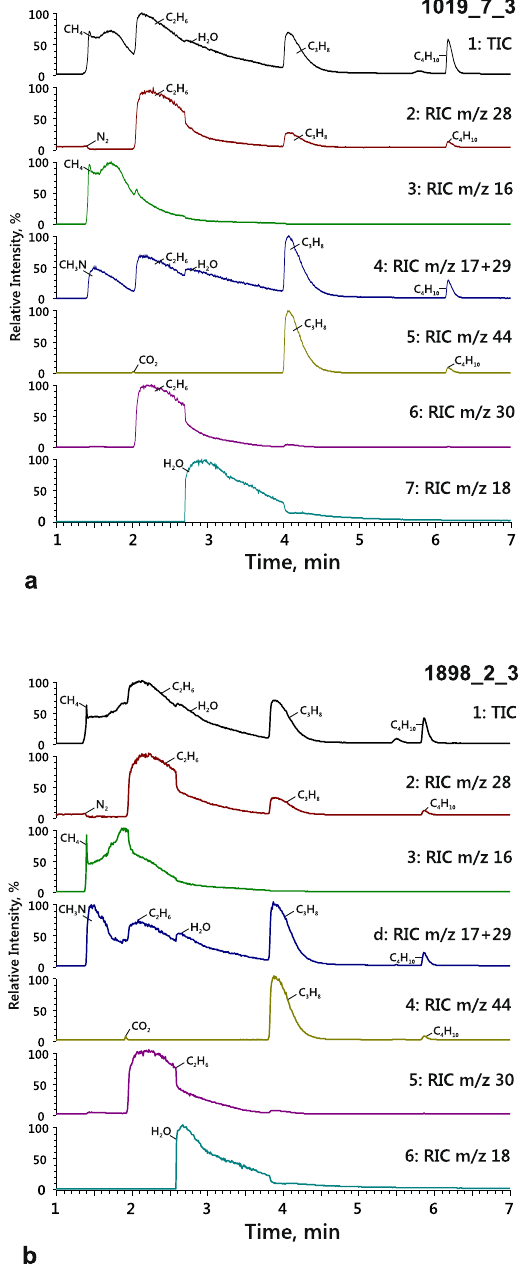
Figure 6. Fragments of chromatograms of quenched fluids extracted from Pt capsules after runs 1019_7_3 ( a ) and 1898_2_3 ( b ). 1 = Total ion current (TIC) chromatograms; 2 = Reconstructed ion chromatograms (RIC) m/z 28 that characterise traces of molecular nitrogen, ethane, propane and butane; 3 = RIC m/z 16: methane; 4 = RIC m/z 17 + 29: methanimine; 5 = RIC m/z 44: traces of carbon dioxide, propane and butane; 6 = RIC m/z 30: ethane; 7 = RIC m/z 18: